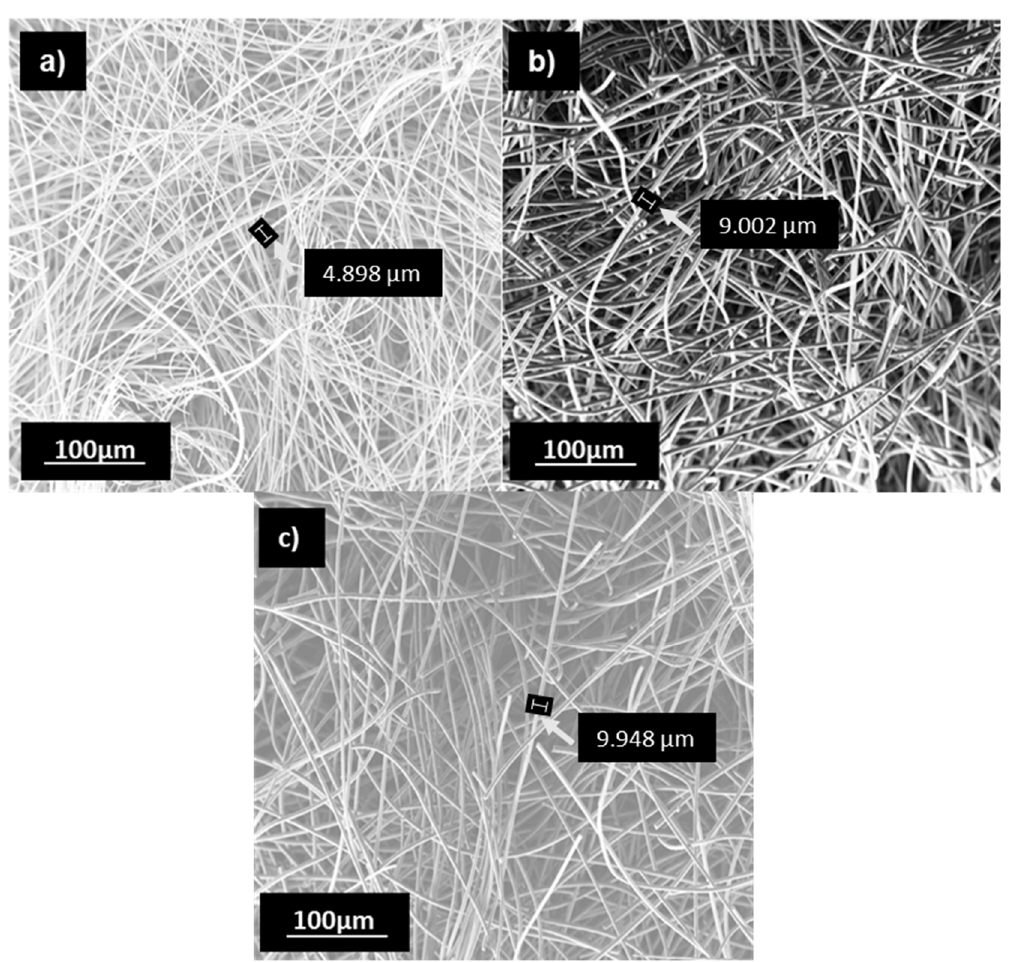
Figure 2. SEM image of surface morphologies. ( a ) 650 ° C -27 h air. ( b ) 650 ° C -27 h nitrogen ( c ) un- treated GF.